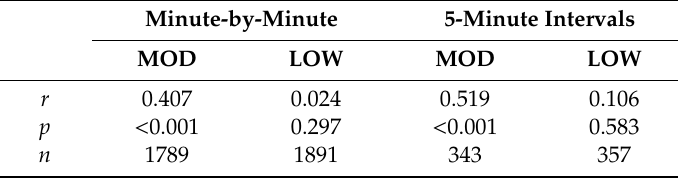
Table 1. Pearson correlations between HR and accelerometry data during different time intervals. Minute-by-Minute 5-Minute Intervals MOD LOW MOD LOW r 0.407 0.024 0.519 0.106 p <0.001 0.297 <0.001 0.583 n 1789 1891 343 357 MOD = Moderate-intensity aerobic session, LOW = Low-intensity balance session.